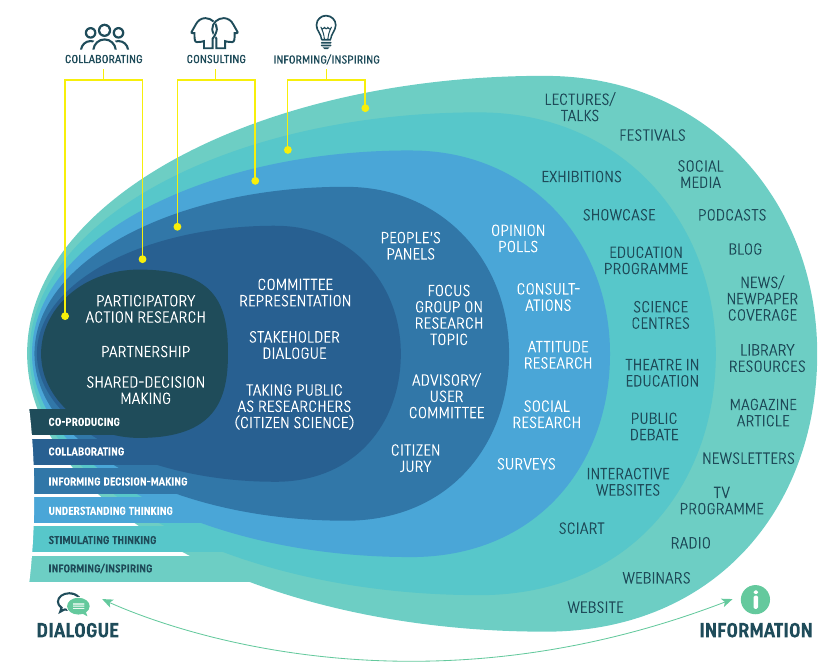
figure 1: UcD ‘avocado’ of public engagement activities (source: UcD Public engagement Working Group,